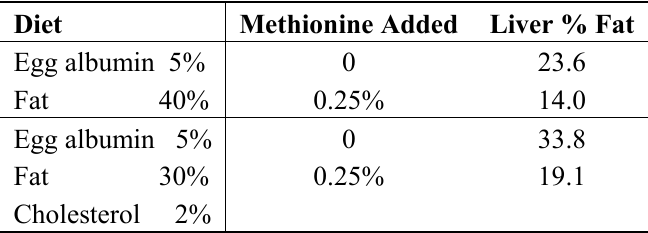
Table 2. Effect of Methionine (from [7]).